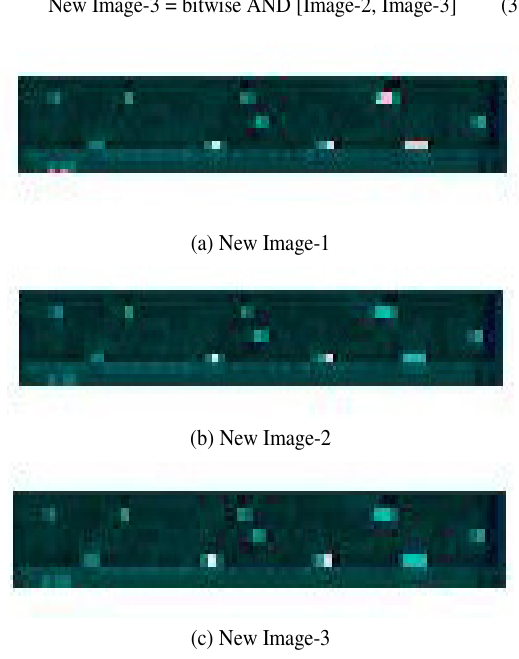
Figure 16: New Segmented Images